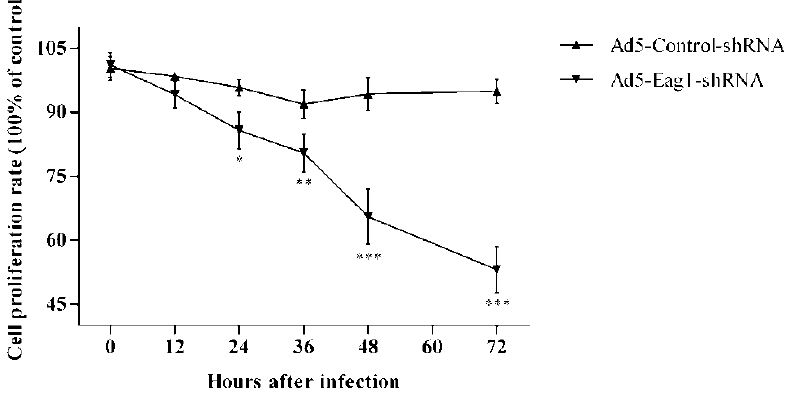
Figure 4. Eag1 silencing inhibits the proliferation of MG-63 cells. CCK-8 assay showing that the proliferation of MG-63 cells was signi fi cantly reduced after infection with Ad5-Eag1-shRNA. Data were normalized using the values obtained for untreated cells (negative control, NC) and presented as mean ± SD ( n = 6). * p < 0.05, ** p < 0.01, *** p < 0.001.